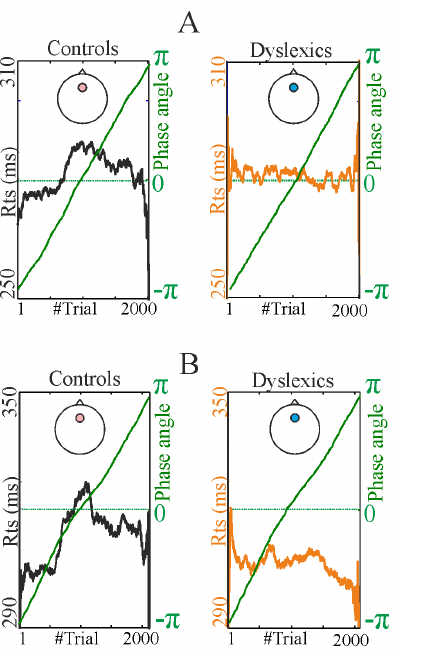
Figure 5. Task performance correlated with delta phase by conditions. Panel A: 2 Hz condition. Panel B: 1.5 Hz condition. Both panels show RT-phase correlations from the most representative electrode (from the electrode approximately corresponding to FCz in the 10–20 electrode location system, see Figure 1). Trials are sorted according to their phase angle in ascending order. Trials with a prestimulus delta phase of – p are followed by trials with prestimulus delta phase ascending towards + p . The phase angle across the trials is represented by the green line. The corresponding RT value is represented by the blue line. The non-linearity of the blue line with respect to the green line for the control participants indicates that prestimulus delta phase predicts RT. For visualisation purposes the RT plots are smoothed using a 500 point sliding window.